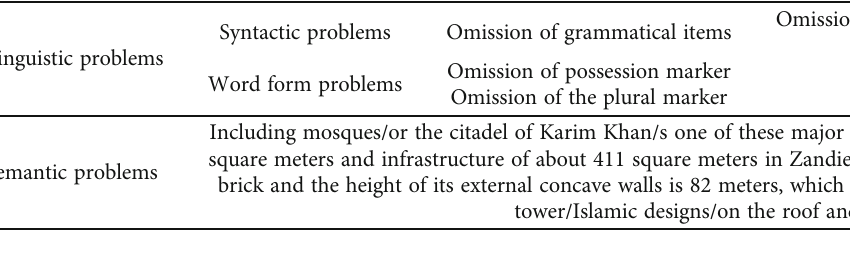
Table 7: Linguistic and semantic problems of English translation of the Arg-e-Karim Khan